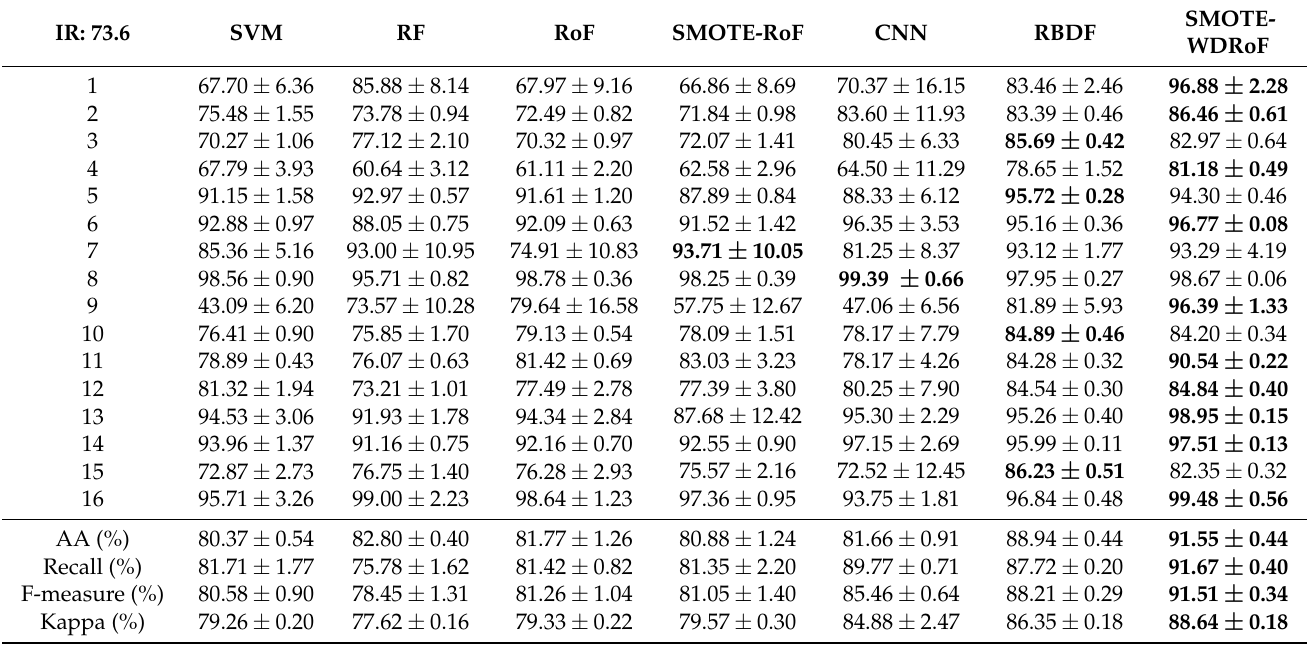
Table 2. Classification results (%) of the Indian pines AVRIS image, respectively obtained by SVM, RF, RoF, SMOTE-RoF, CNN, RBDF and the proposed SMOTE-WDRoF in the case of the imbalance ratio of 73.6. IR: